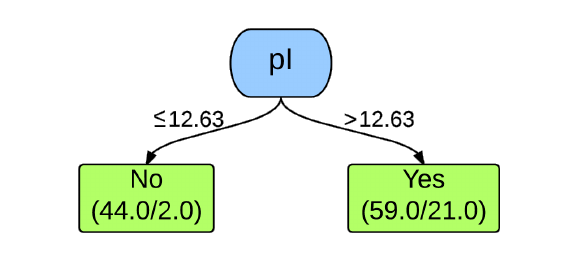
Figure 1: Decision tree for both 10-fold and leave-one-out cross-vali- dation J48 classifier of the first, second, and third analyses. The values indicated on the branches represent the rule or decision used for making the classification. The boxes at the bottom represent the clas- sifications with the number of PAMAM dendrimers classified as such on the left and the number of exceptions (misclassifications) on the